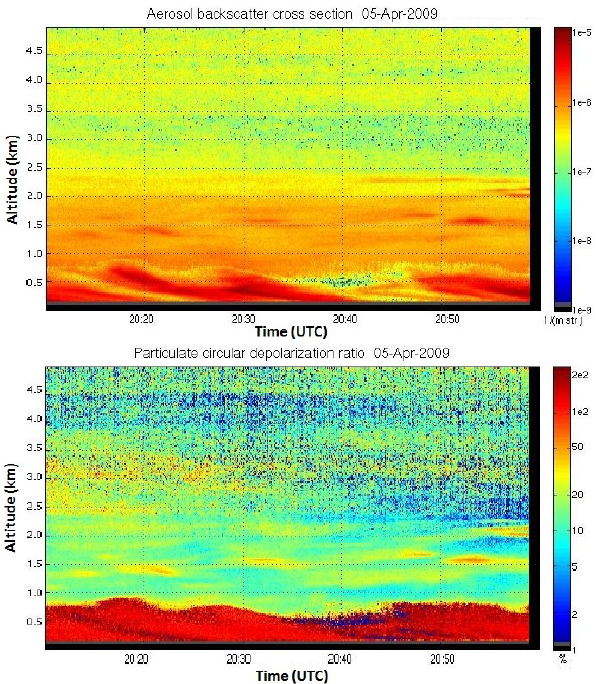
Fig. 10. AHSRL measurements of backscatter cross section (top panel) and particulate circular depolarization ratio (bottom panel) between 20:10 and 21:00UTC on 5 April 2009. From 20:30–20:40, the top of the ice crystal cloud was ∼ 610m, where the E-AERI is